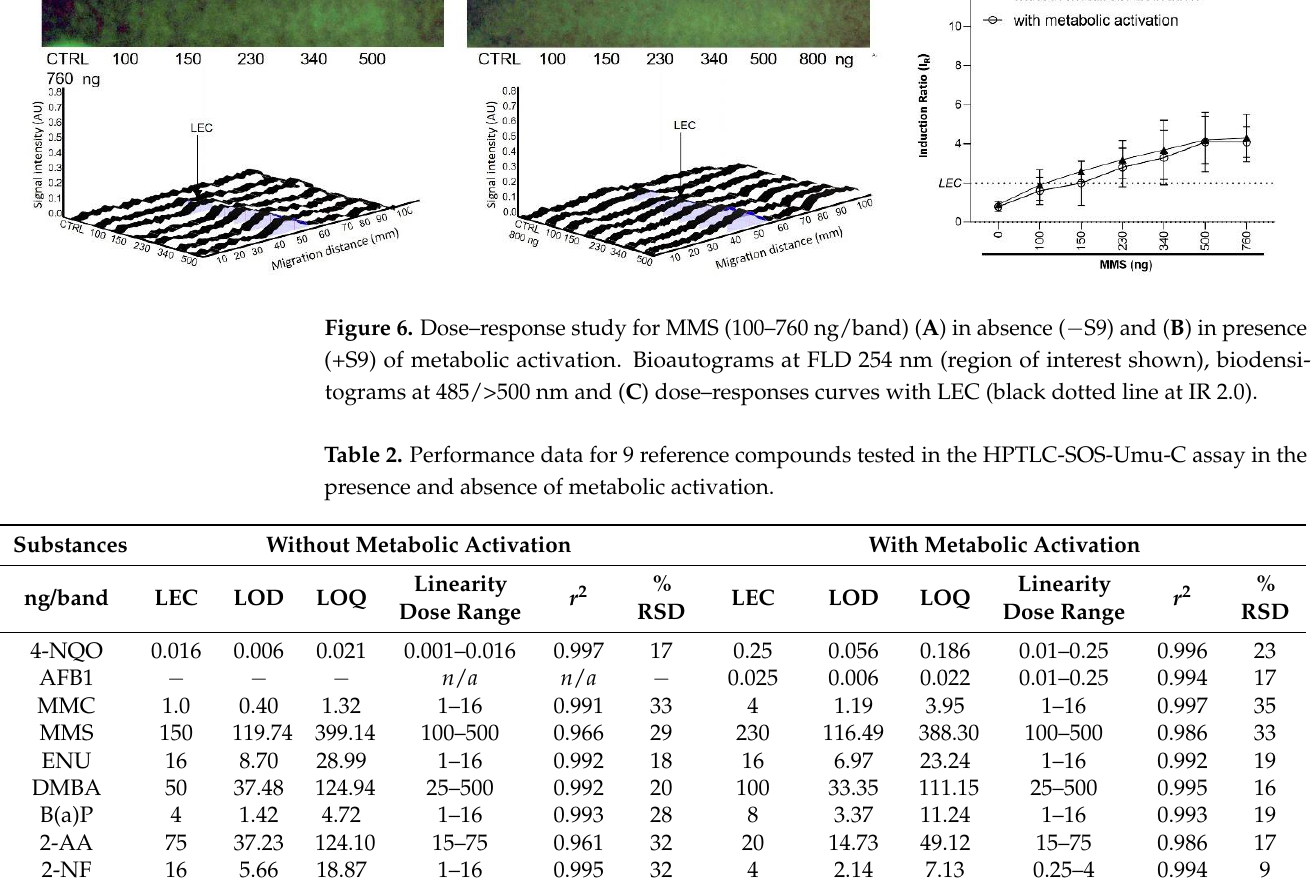
Table 2. Performance data for 9 reference compounds (RC) tested in the HPTLC-SOS-UmuC assay in the presence and absence of metabolic activation.